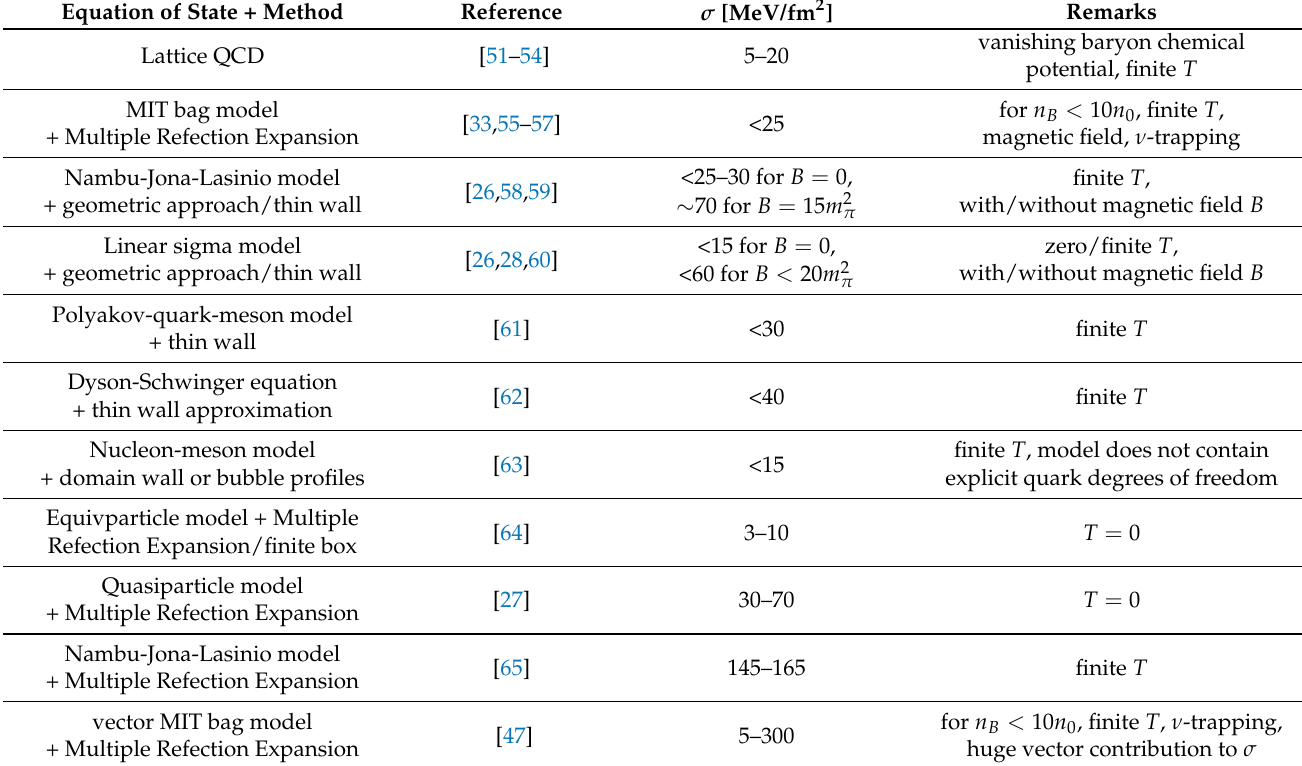
Table 1. Summary of microscopic calculations of the surface tension. See the works listed in the second column and references